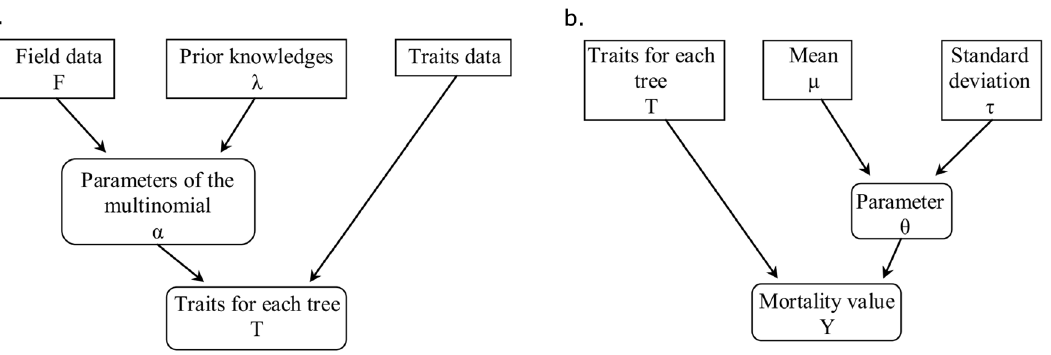
Figure 3. Two steps of model construction. a: The functional traits are uncertain variables. The contingency matrix F and the prior information l are used in the Dirichlet law to compute the trait variables T for each tree. b : Parameters h of the model are estimated using a Metropolis-Hastings algorithm with proposal law h prop * N ( m , t ) . Parameters h and traits T are then used in the final model to compute the mortality measure y for each tree.